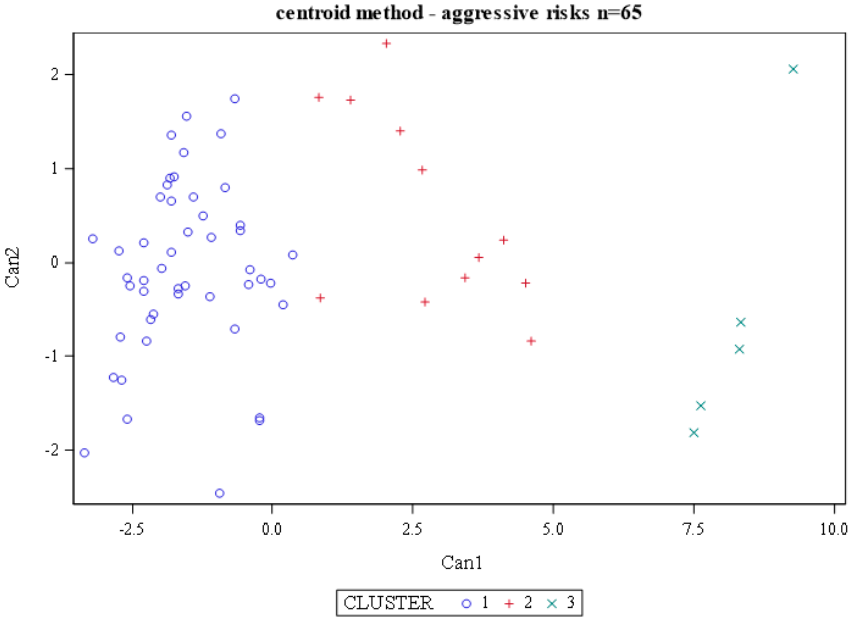
Figure 1. Centroid cluster analysis of 3D nuclear profiling of circulating tumor cells (CTCs) from 65 patients with intermediate risk prostate cancer. A combination of telomere parameters (Materials and Methods) led to the stratification of patients into clusters, each with a different level of genomic instability and a different risk to progression. Patients in cluster 3 (green) had the lowest risk (20%) to progression, while those in cluster two (red) and cluster 1 (blue) had an intermediate (50%) to high risk (68.75%), respectively.